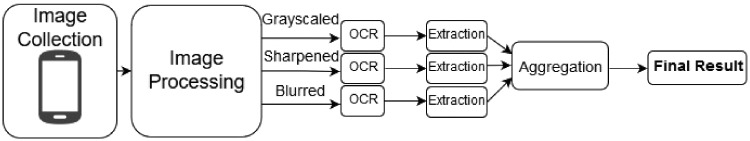
Architecture of the label recognition algorithm